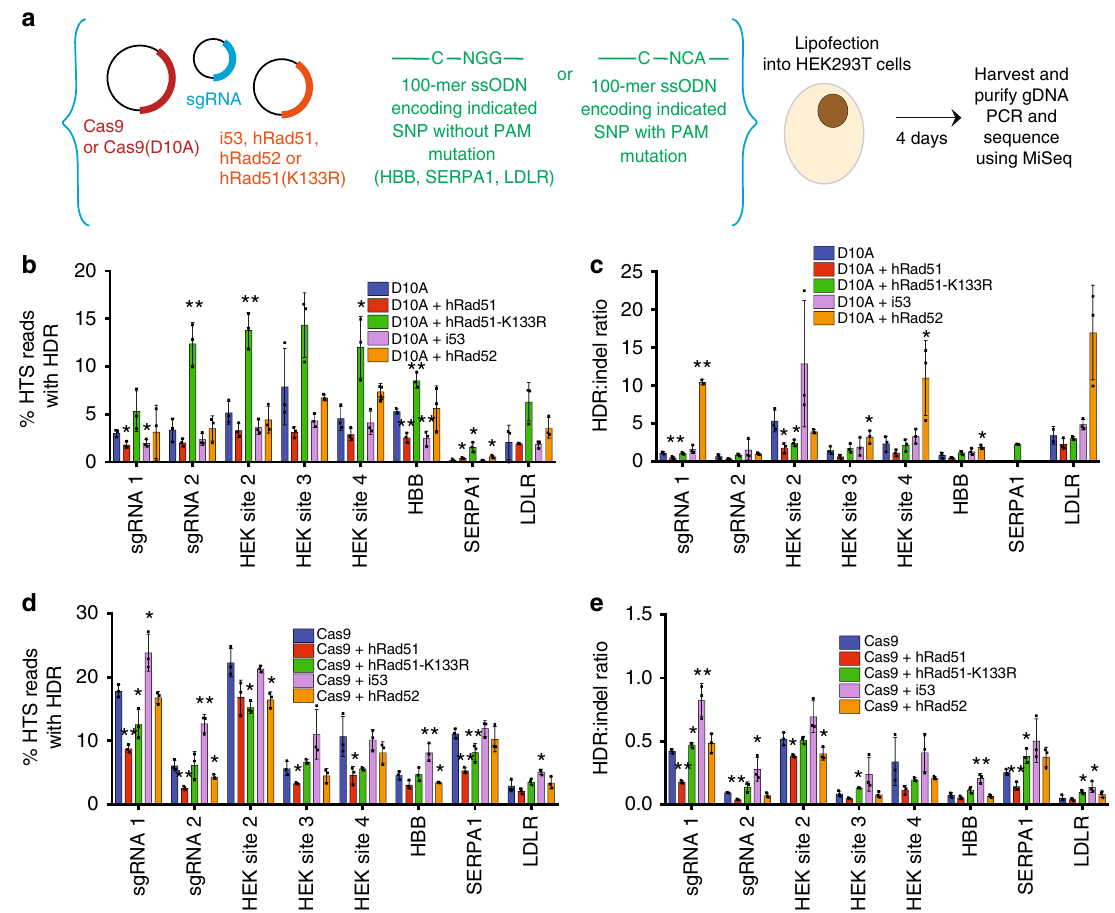
Fig. 2 Manipulation of HDR frequency by global manipulation of cellular repair proteins. a Overview of experimental procedure. b , d HDR frequencies, measured by high-throughput DNA sequencing of unsorted HEK293T cells at eight endogenous genomic loci. c , e HDR:indel ratio at eight loci. b , c Data associated with treatment of Cas9(D10A) nickase and d , e with Cas9 nuclease. All data are shown as individual data points and mean ± s.d. for n = 3 independent biological replicates, performed on different days. Students two-tailed t -test was used to determine statistical signi fi cance between the indicated sample and in b Cas9(D10A) alone or in d Cas9 alone. (*): 0.01 < p < 0.05; (**): 0.001 < p < 0.01. Source data are provided in the Source Data fi three sites (LDLR, HBB, and SERPA1). Since indels are generated much less ef fi ciently with nick-induced HDR compared to DSB- induced HDR (Fig. 1e), we sought to test whether PAM-blocking mutations are necessary for nick-induced HDR and to de fi ne the region between the PAM and target mutation that can support ef fi cient HDR.